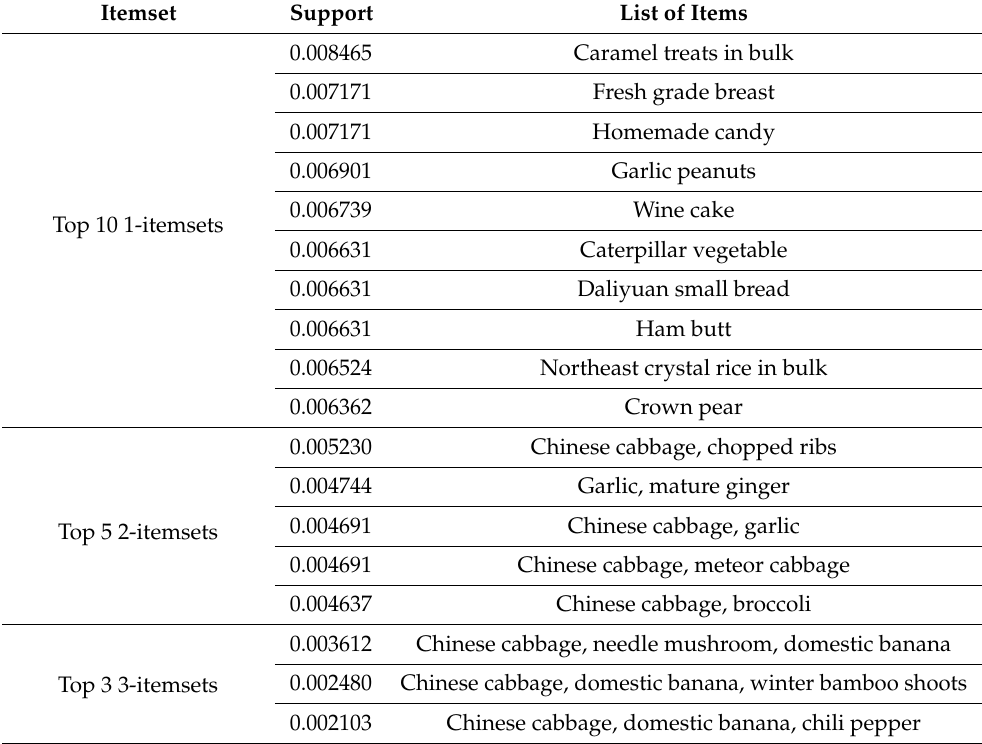
Table 3. Top frequent